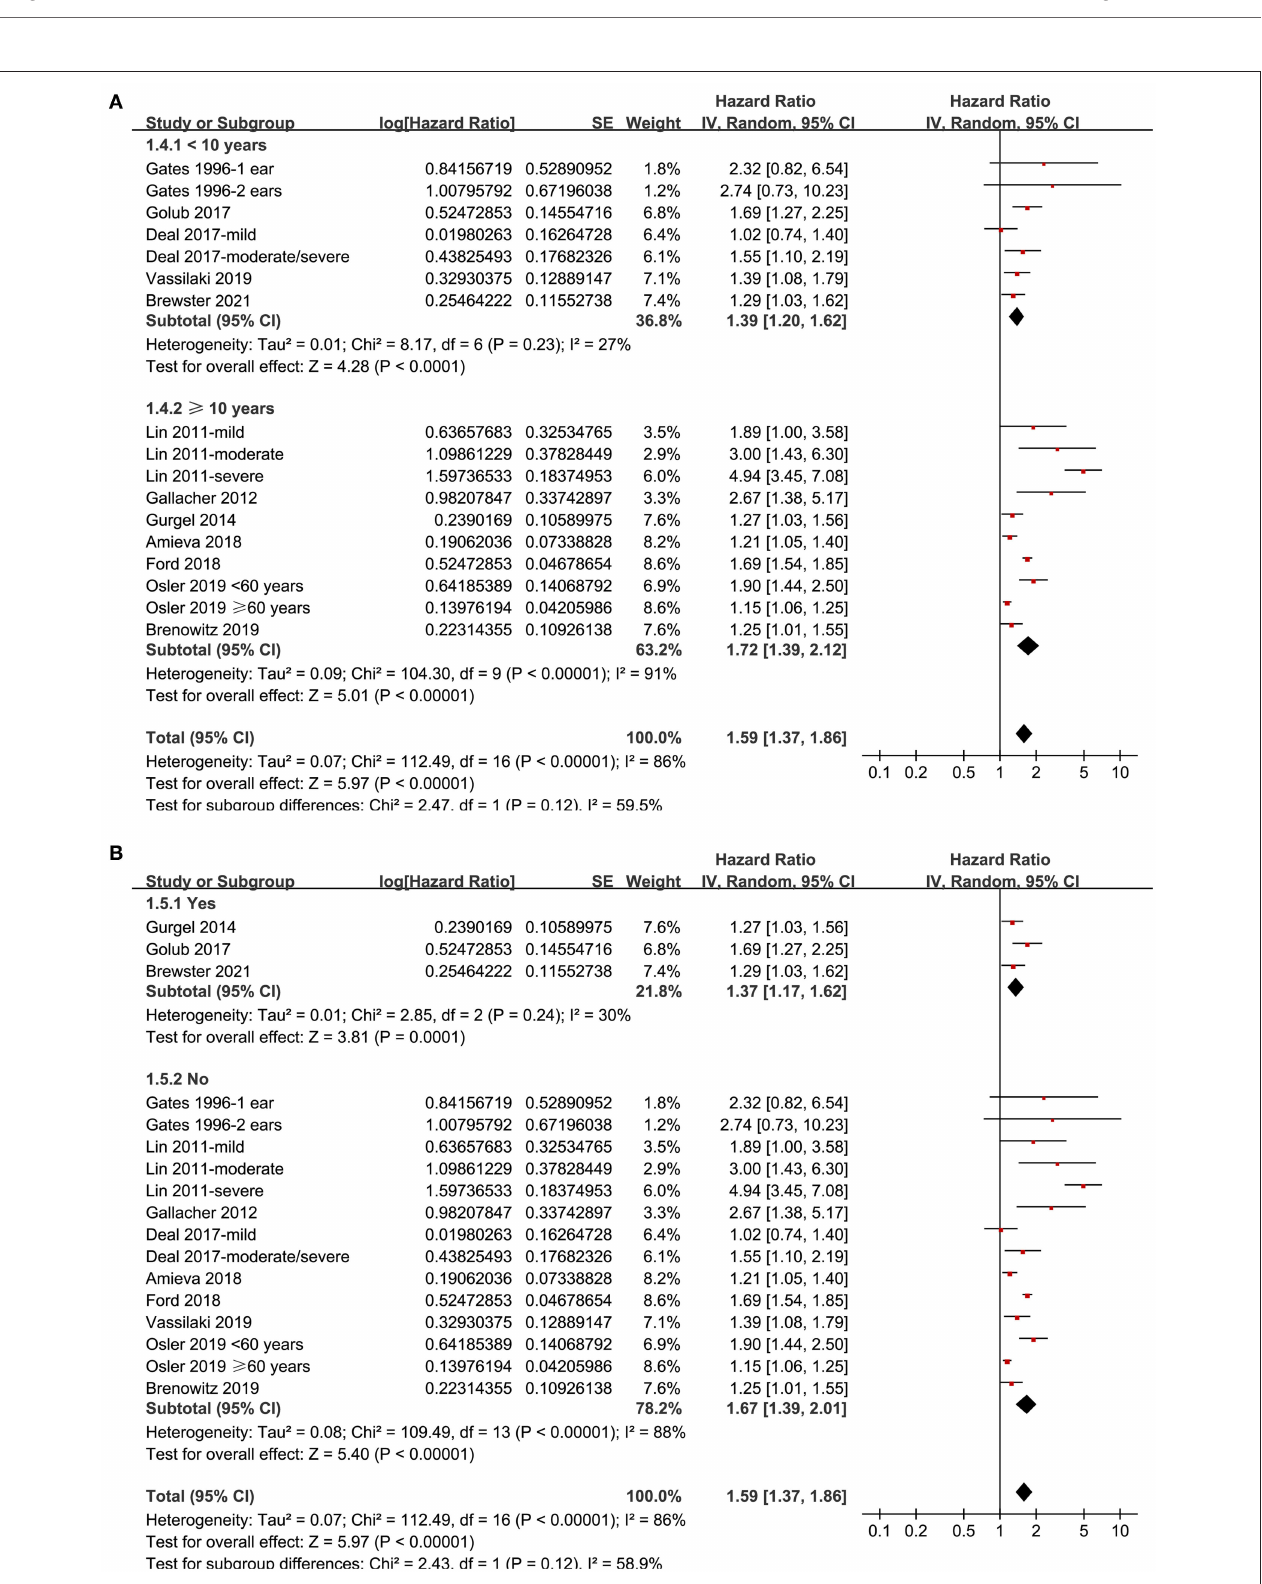
FIGURE 4 | Subgroup analyses for the outcome of all-cause dementia. (A) Subgroup analysis according to the mean follow-up duration, and (B) subgroup analysis according to whether the status of the apolipoprotein E (APOE) genotype was adjusted.